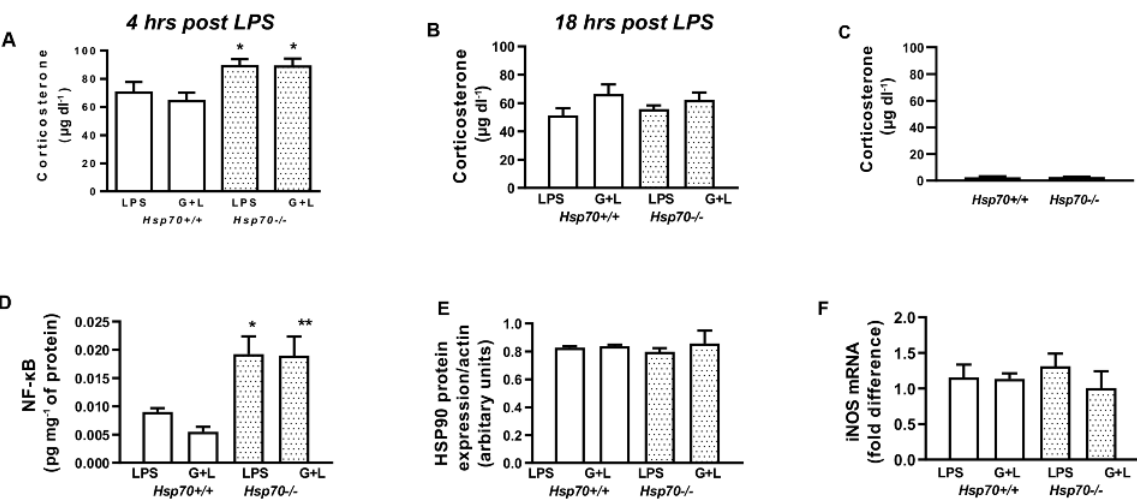
Figure 3. E ff ect of LPS on plasma corticosterone levels and lung tissue levels of HSP90, NF-kB, iNOS and in Hsp70+/+ and Hsp70-/- mice. All mice received, i.p. GLN (0.75 mg kg -1 ) or normal saline and one hour later LPS (150 μ g); serum and lung tissue was assessed 4 hrs later. Plasma corticosterone levels (A & B) were measured using commercial RIA kit at 4 and 18 hrs after LPS administration, respectively. Basal levels were assessed before any treatment (C). ELISA kit was used to specifically quantify activated (phosphorylated) NF-kB p65 (D). Western blot analysis of HSP90 expression was assessed (E). RT-PCR was performed for the detection of iNOS mRNA expression (F). Means ± SEM. Asterisks (*) depict statistical di ff erence between genotypes exposed to the same treatment. *, p < 0.05; **, p < 0.001. Each graph shows a representative experiment of at least three independent